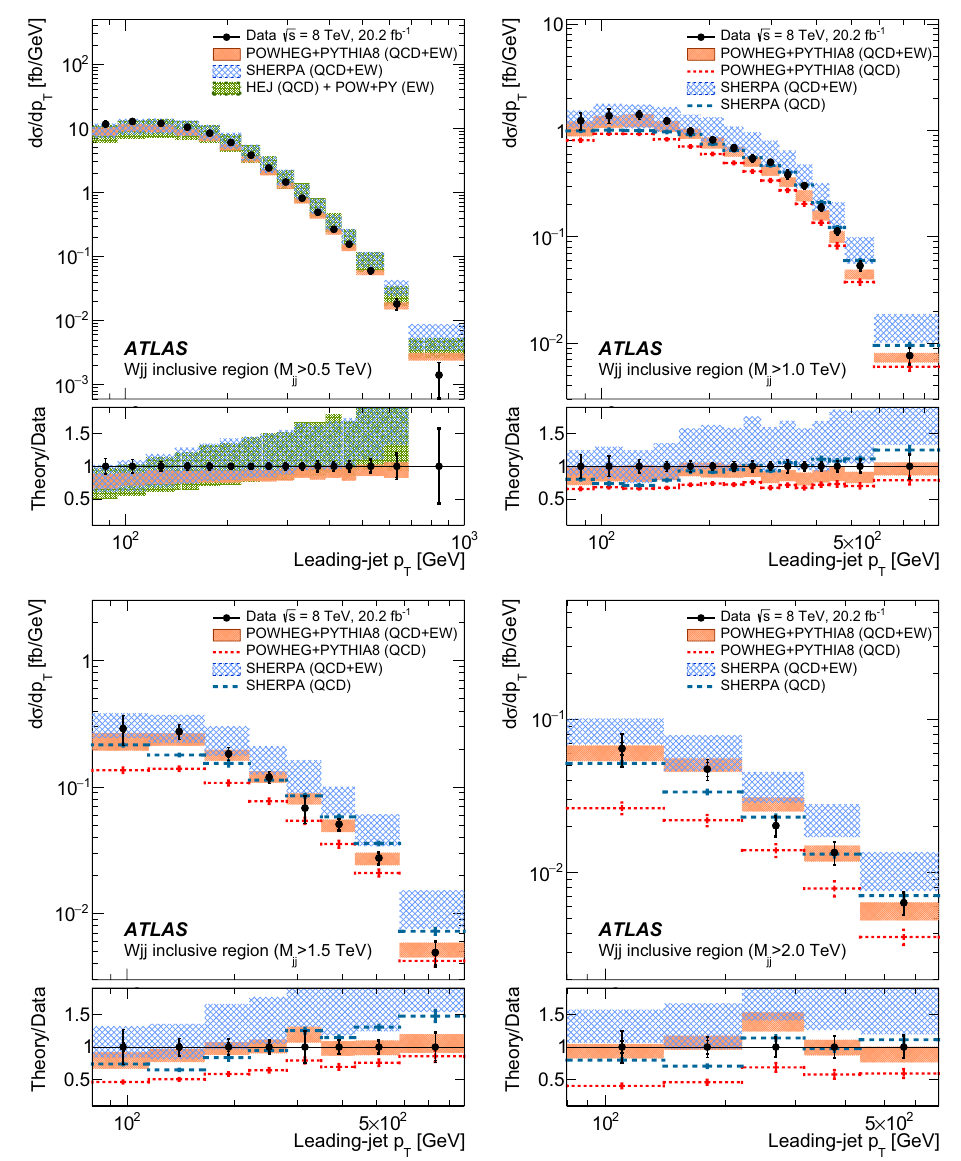
Fig. 40 Unfolded absolute differential W jj production cross sections as a function of leading-jet p T for the inclusive fiducial region when the dijet invariant mass threshold is progressively raised in 500 GeV incre- ments from 0.5 TeV ( top left ) to 2.0 TeV ( bottom right ). Both statistical